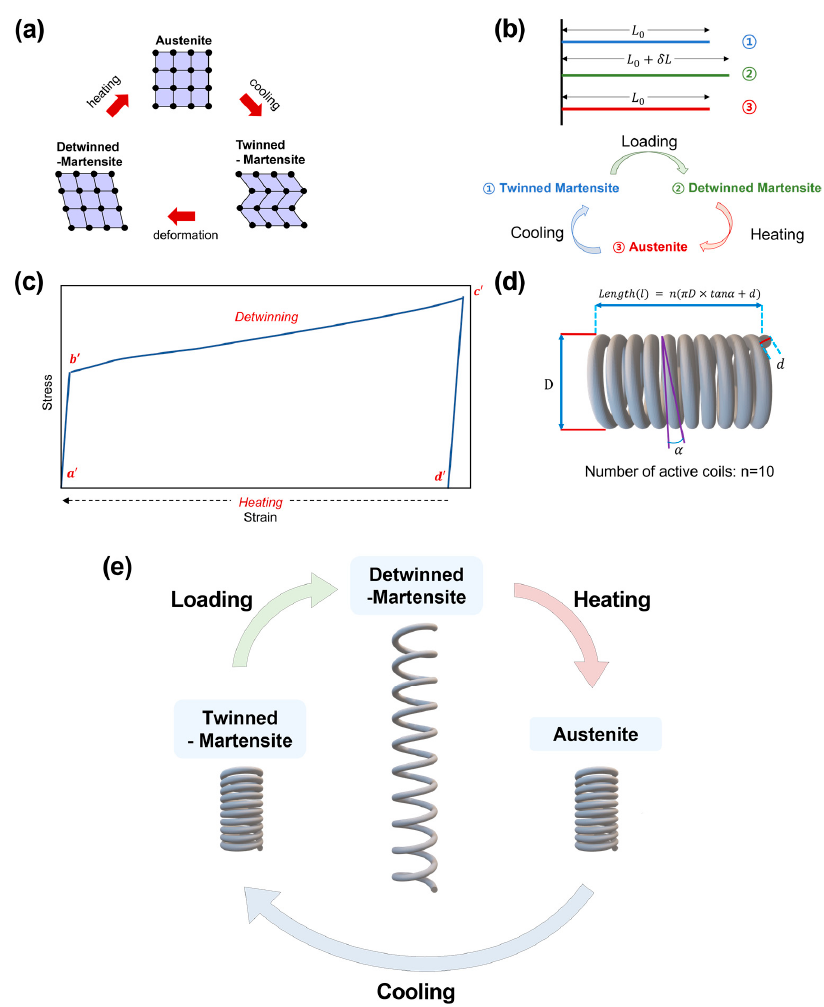
Figure 3. ( a ) Phase transformation of SMA. ( b ) The length changes according to the phase change of SMA. ( c ) Stress–strain graph when the phase change of SMA occurs. ( d ) Variables of SMA spring. ( e ) Phase transformation of the SMA spring corresponding to length change [32,41,42] .